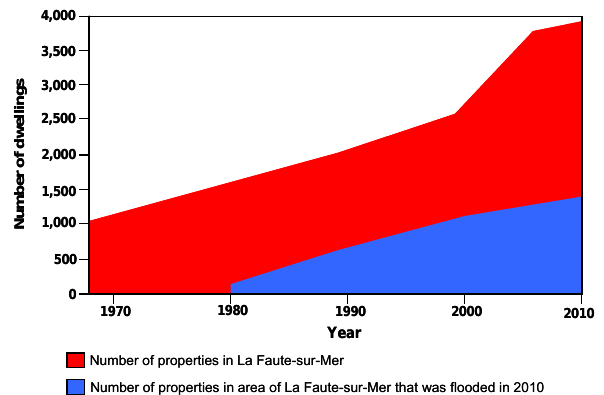
Fig. 4. Aerial view of the damage to a section of coastal flood defences in Vendée. (Source: Maxiscience, 2010).